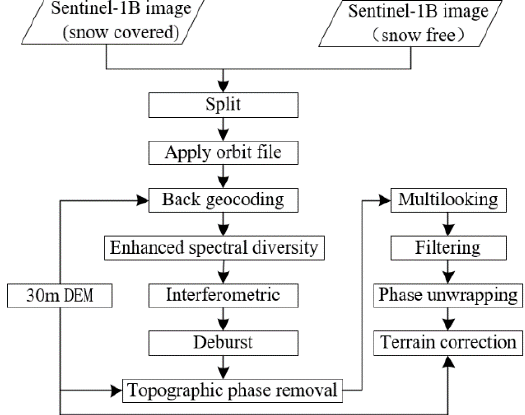
Figure 7. Flow chart for obtaining initial data. Orbit corrections can effectively avoid systematic errors caused by orbit factors. For image registration, the resampling method is based on bilinear interpolation, and by enhancing the spectral diversity, offset correction of the range and azimuth directions is performed on the slave band. The interferogram is obtained by multiplying the conjugate of the complex values of the master and slave images, as shown in Figure 8a; the topo- graphic phase is removed from the interferogram for phase flattening. Using Goldstein phase filtering can greatly reduce the residual error in subsequent processing and im- prove the phase unwrapping accuracy. In the Linux environment, the phase unwrapping